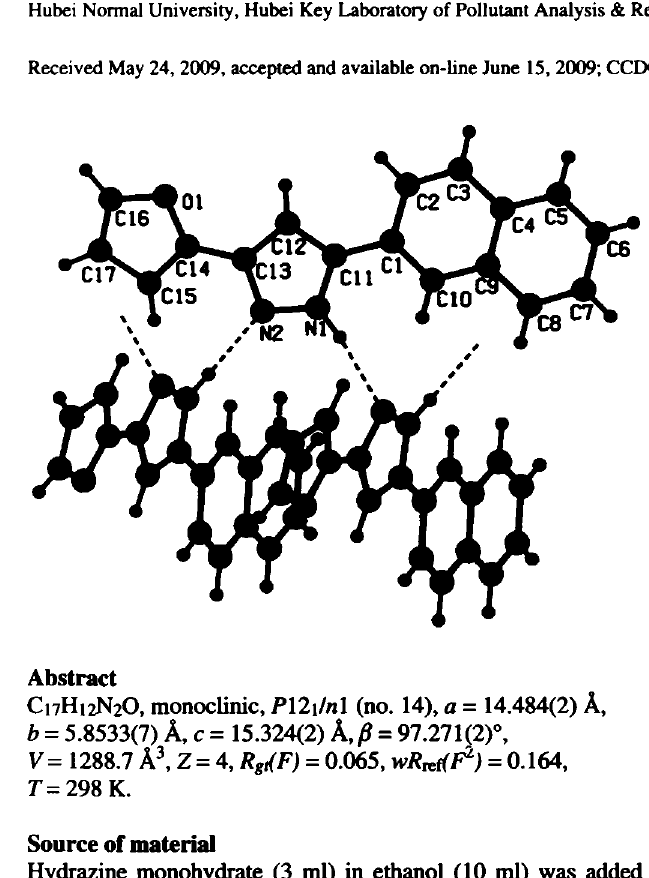
Table 1. Data collection and handling.